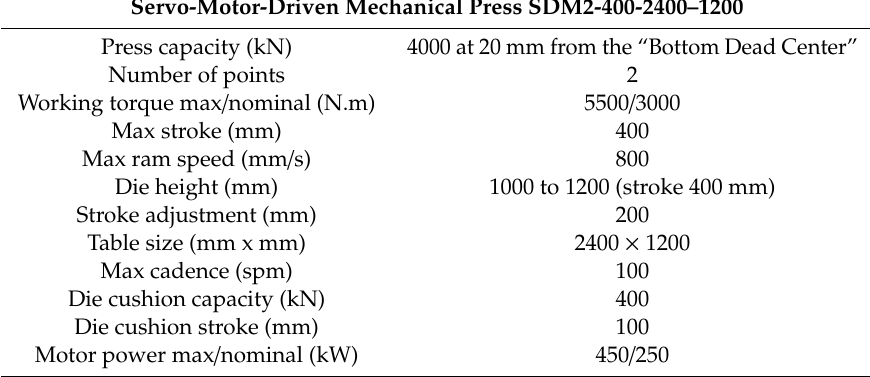
Table 1. Characteristics of the 4000 kN servo-motor-driven mechanical press.